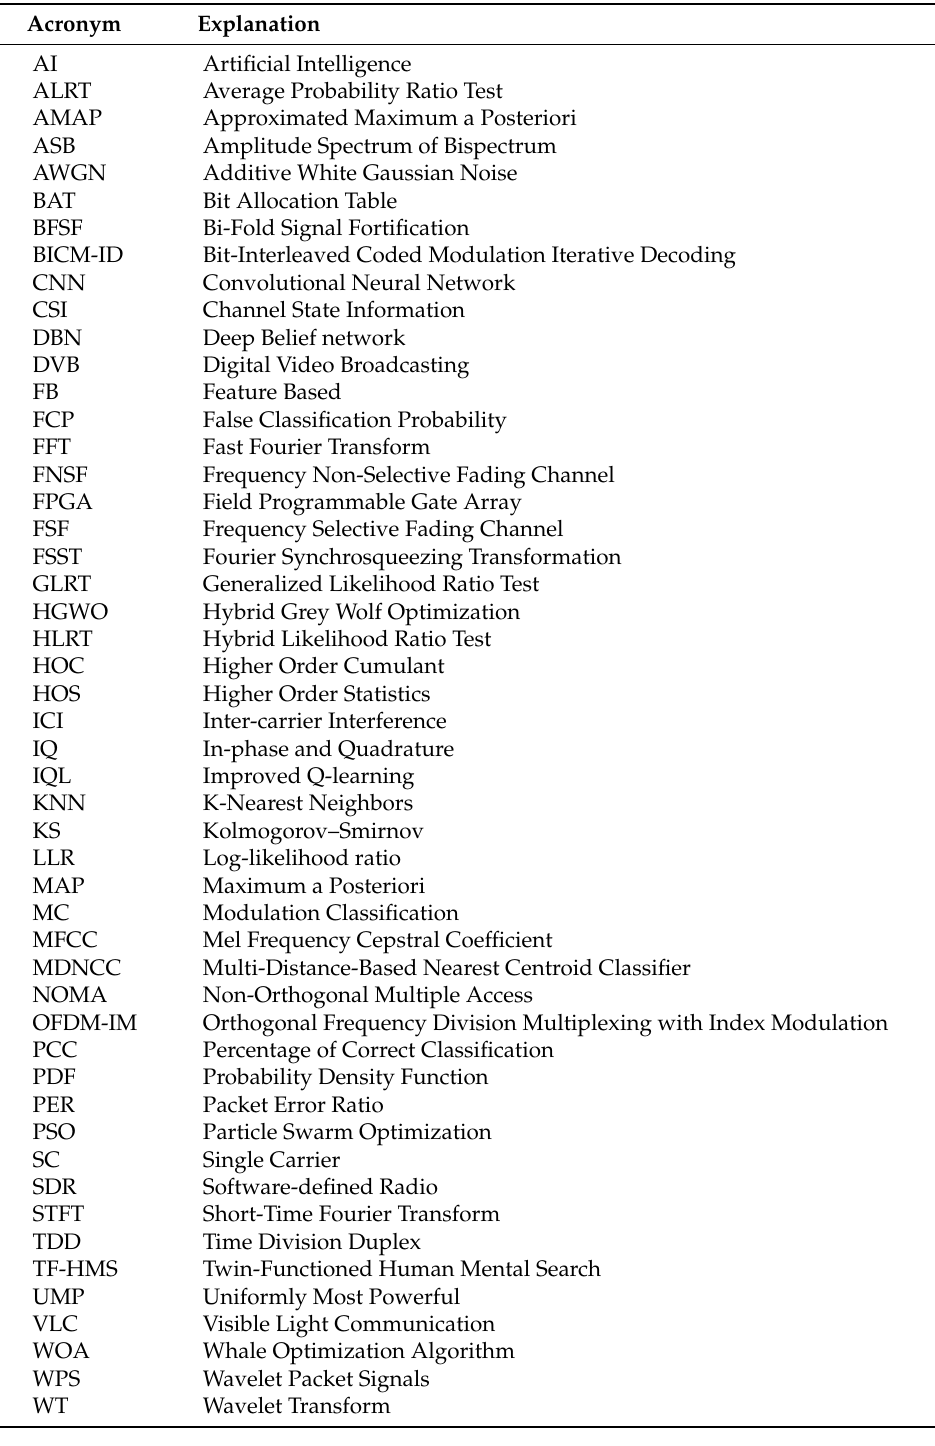
Table 1. List of abbreviations in alphabetical